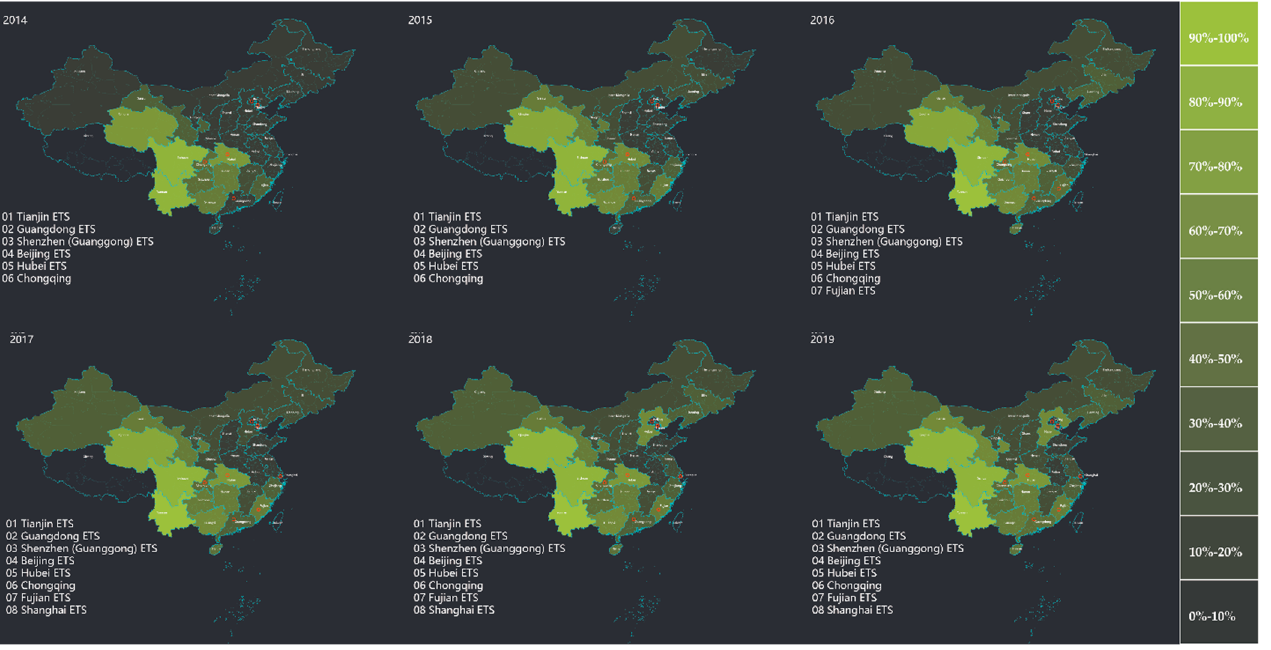
Figure 3. The Sustainable Energy Strategy (SUB) change across 30 selected provinces in China (2014 –2019).